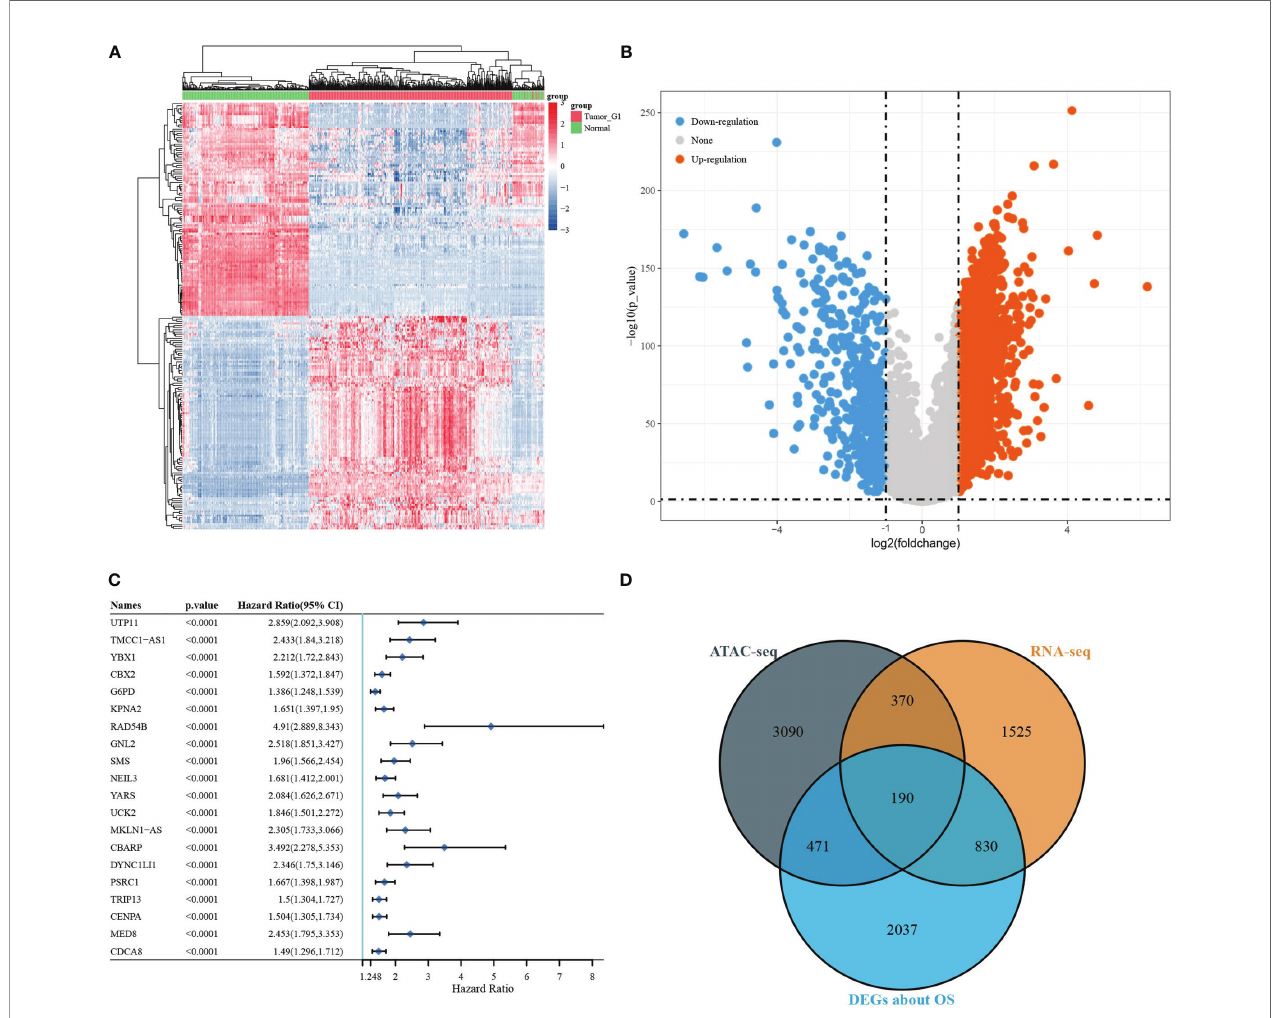
FIGURE 3 | Differentially expressed gene screening. [ (A) volcano map of differentially expressed genes; (B) heat map of differentially expressed genes; (C) DEGs associated with OS; (D) Venn diagram showing overlapping genes for ATAC-seq, RNA-seq, and survival-associated